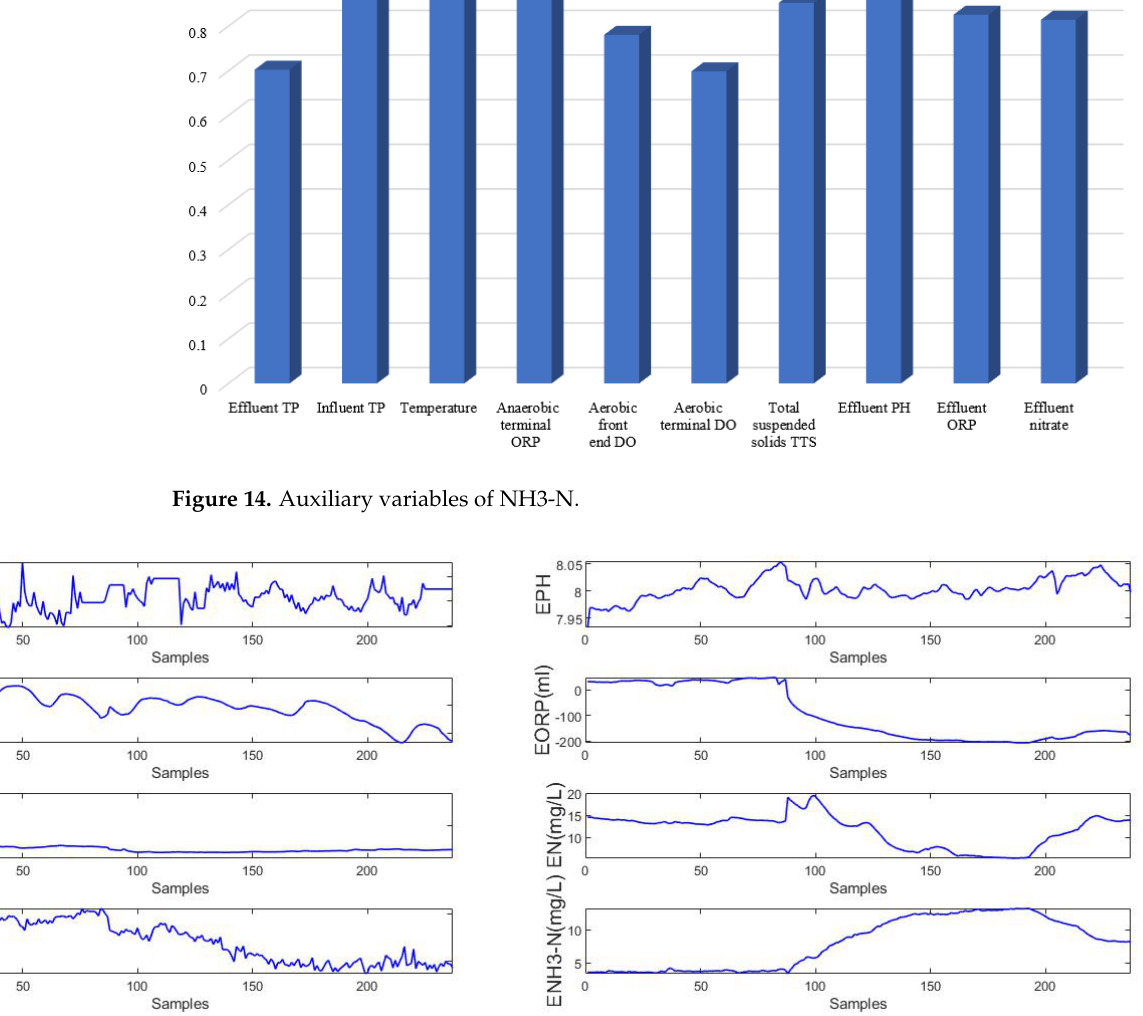
Figure 15. Original data of